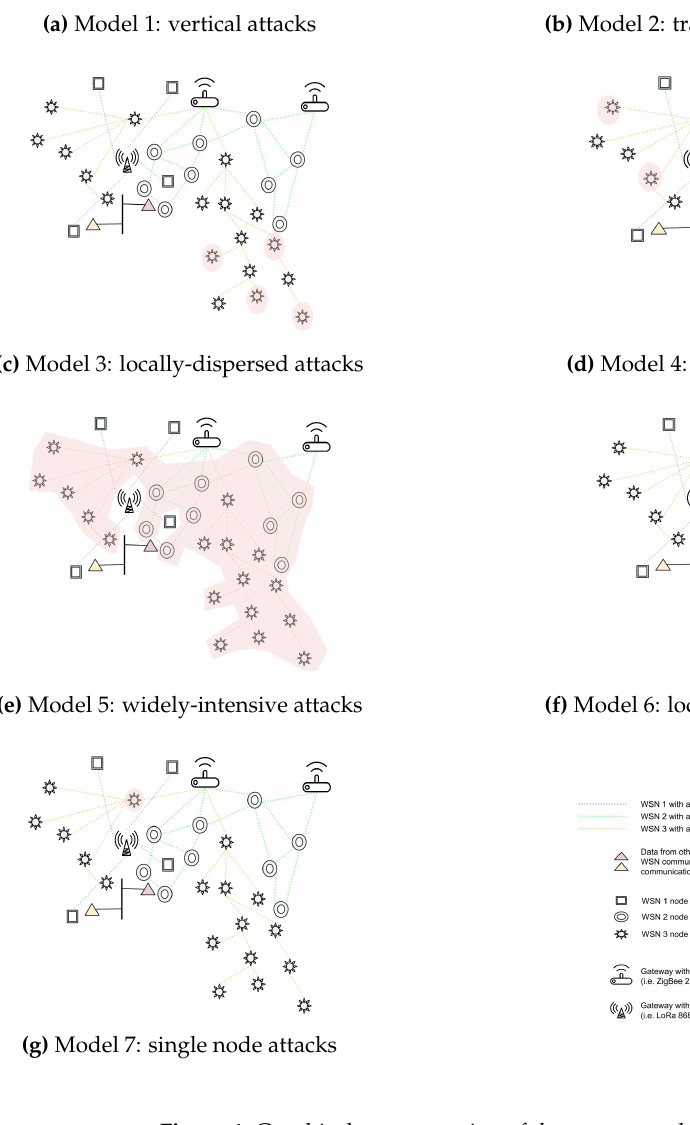
Figure 4. Graphical representation of the seven attack